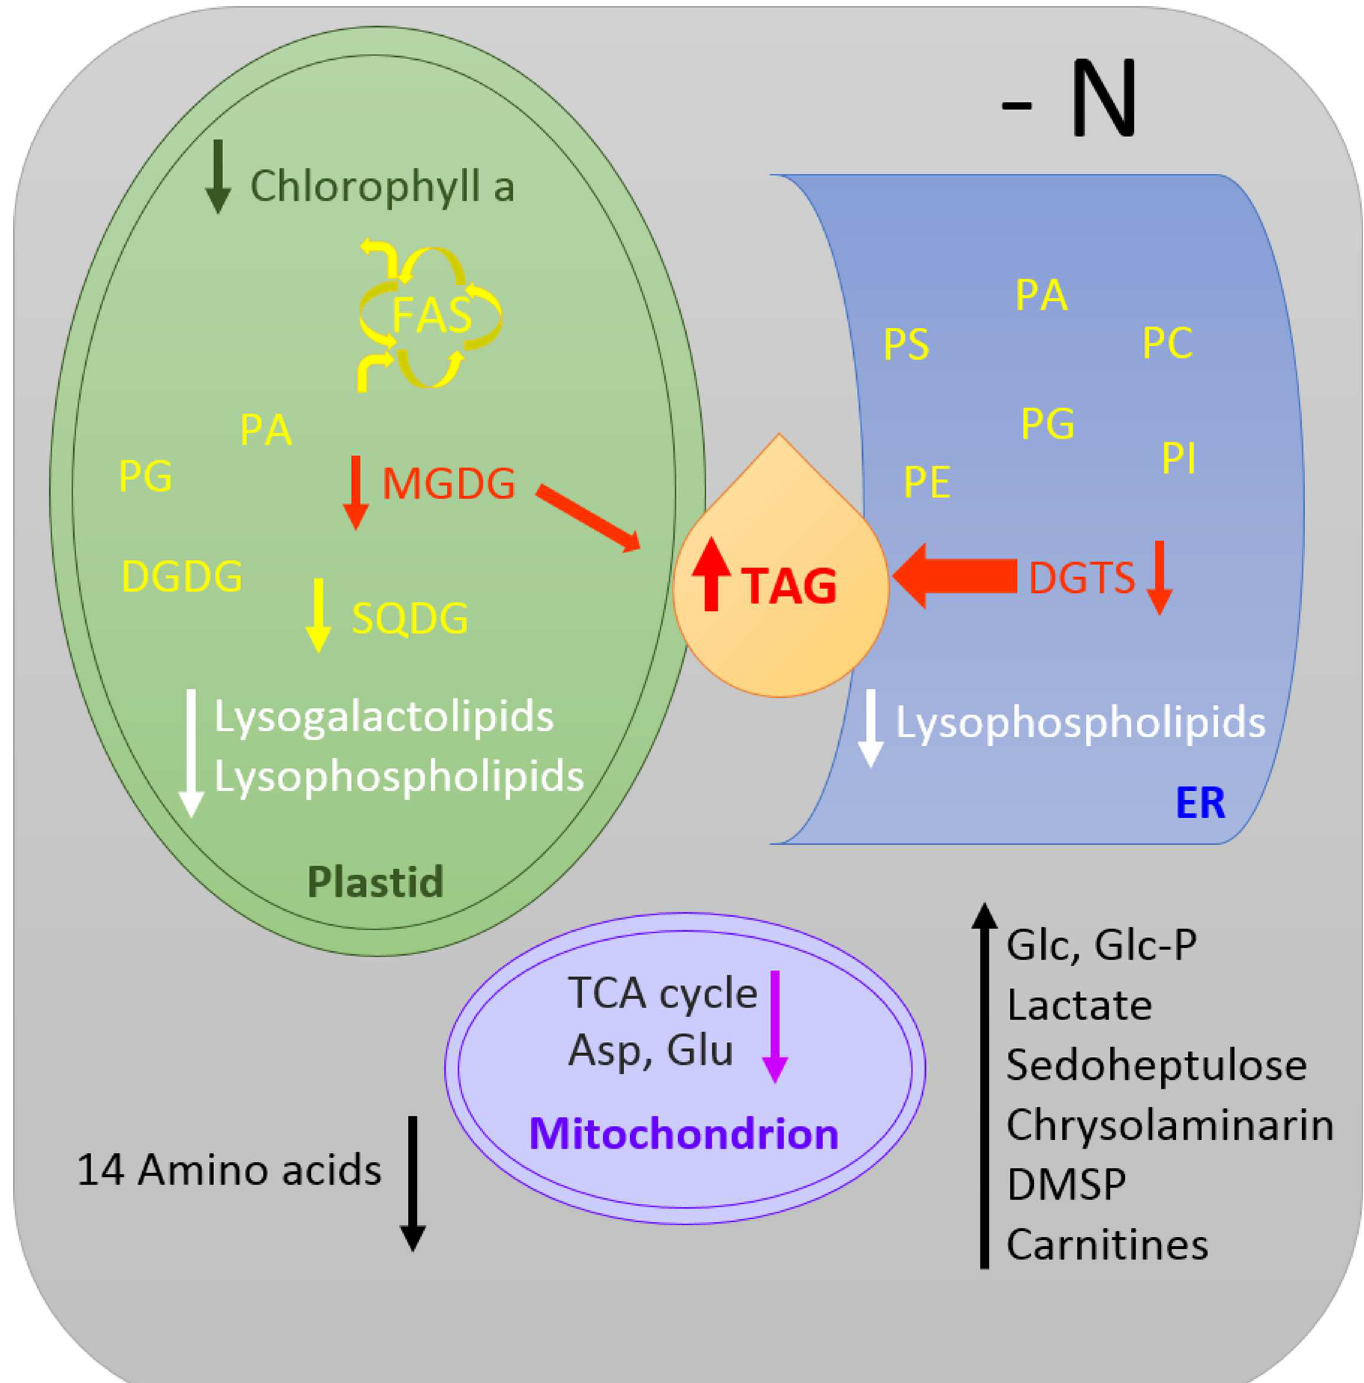
Fig 6. Summarizing scheme of changes of lipidome and metabolome under N-depletion. The scheme displays the main observations followedby N- depletion.Regarding lipid species (yellow) the main changes affect MGDG, DGTS and TAG, suggestinga major flux from DGTS towards TAG, but there are also evidencefor a participation of MGDG and maybe SQDG. All lysolipidspecies are decreased.The Chl a content is decreasing which suggests together with a decrease of different amino acids towards protein degradation. In addition, the compounds of the TCA cycle are reduced. However, different sugar compoundsas well as S-containingmetabolites and carnitinesare